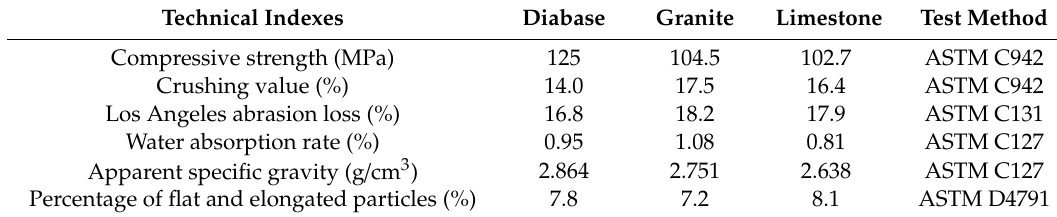
Table 5. Chemical compositions (wt%) of the coarse aggregates.